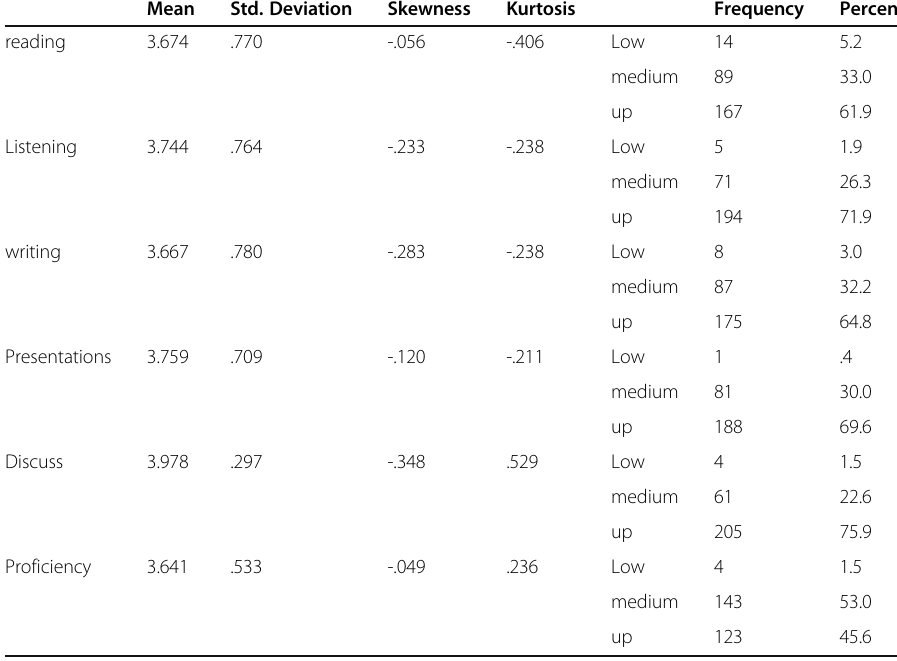
Table 3 Frequency distribution and descriptive indexes of responses in proficiency variables and related items